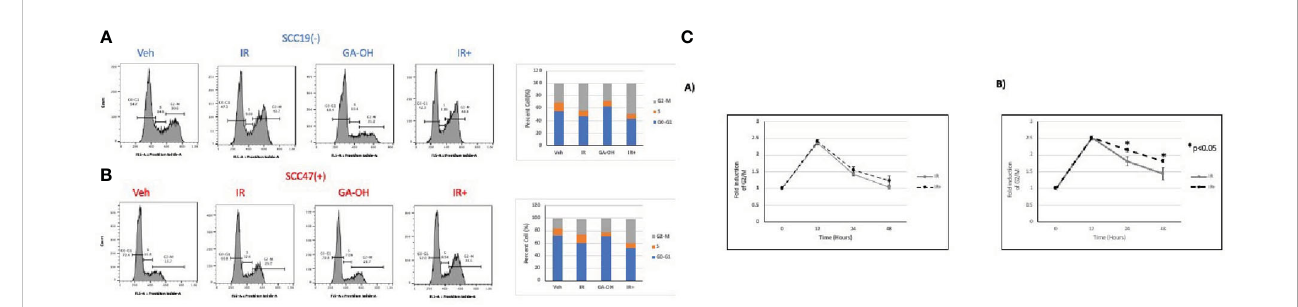
FIGURE 6 Cell cycle changes after radiation and GA-OH treatment. SCC19 (A) and SCC47 (B) cells treated with or without GA-OH were stained with propidium iodide 24 hours post-irradiation and analyzed using fl ow cytometry. In both cell lines, G2-M is the most affected stage of cell cycle and there is an increase in G2-M arrested cells. SCC47 has a higher proportion of cells that are still arrested in G2-M phase after 24 hrs compared to SCC19. (C) Relative temporal changes of the G2-M fraction of cells over a time period of 48 hours in SCC19 (left) and SCC47 (right). Values shown represent means ± standard deviation from 3 independent